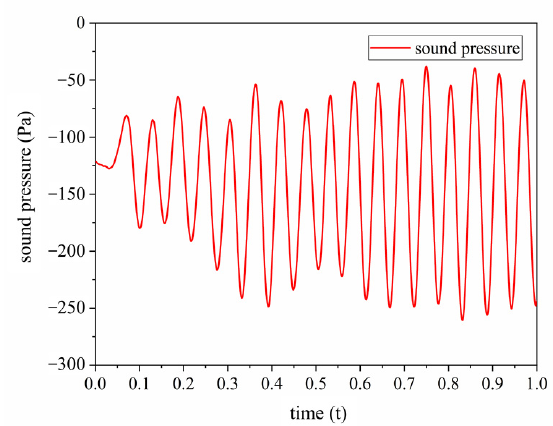
Figure 4. Pressure pulsation of the monitoring point while the inlet speed is 70 km/h.